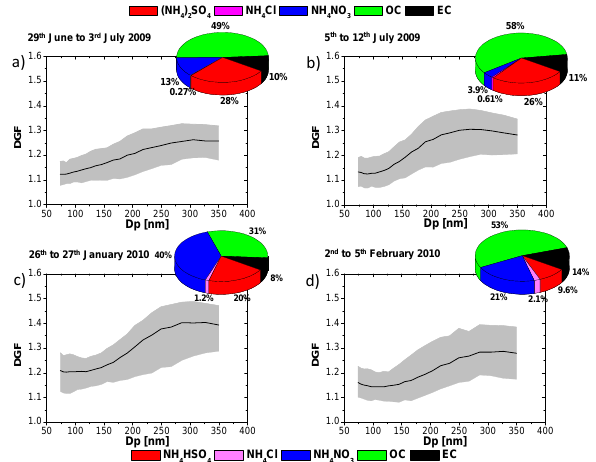
Fig. 6. Growth factor distributions with the mean DGF and 0.1 and 0.9 quantiles for four periods in summer (a, b) and winter (c, d) ob- Figure 6. Growth factor distributions with the mean DGF and 0.1 and 0.9 quantiles in four 3 tained by TDMPS/HDMPS measurements at a RH of 90%. The pie periods in summer (a,b) and winter (c,d) otained by TDMPS/HDMPS measurements at a RH 4 charts show the corresponding volume fractions of the main aerosol of 90 %. The pie charts show the corresponding volume fractions of the main aerosol 5 compounds. compounds. 6